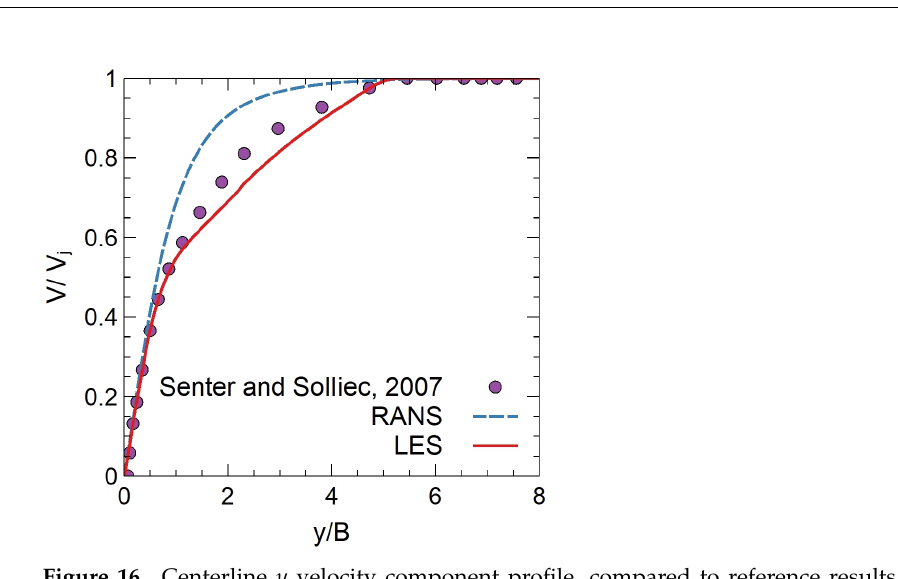
Figure 16. Centerline y velocity component profile, compared to reference results reported by Senter and Solliec [70].